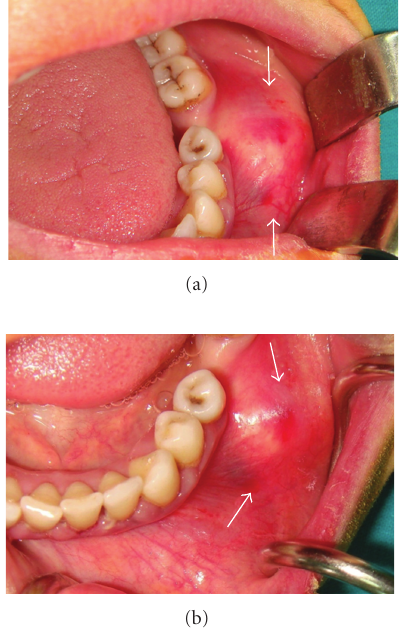
Figure 2: Intraoral view showing a well-defined, round swelling covered by normal oral mucosa on the buccal plate of the left posterior mandible.